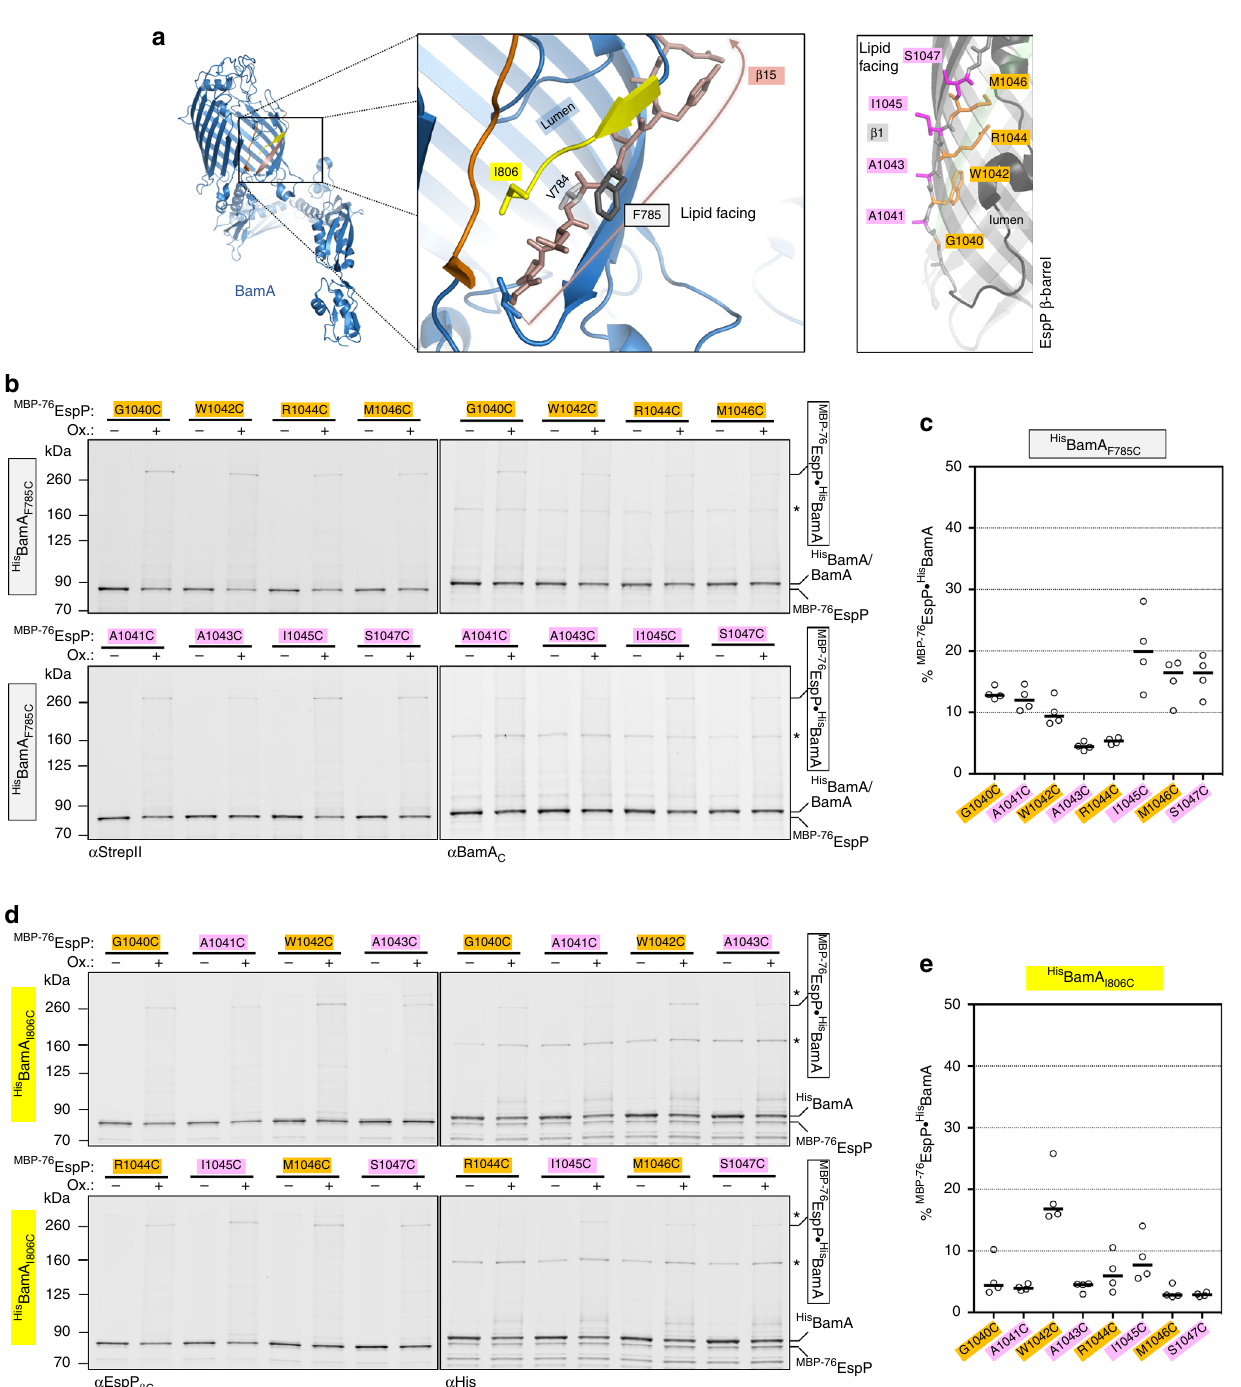
Fig. 4 Bonding of MBP − 76 EspP( β 1) cysteines with lipid-facing cysteines in BamA( β 15/16). a Left, view of outward-facing residues I806 in BamA( β 16) (yellow) and F785 in BamA( β 15) (salmon). Right, view of MBP − 76 EspP( β 1) showing lipid-facing (magenta) and luminal (orange) residues. Residue S1047 is situated at the interface between the outer lea fl et of the OM and the extracellular milieu 54 and is the last membrane embedded residue of β 1. b , d BL21 (DE3) that expressed MBP − 76 EspP with a single cysteine substitution in β 1 and His BamABCDE with a His Bam I806C ( b ) or His BamA F785C ( d ) substitution were mock-treated ( − ) or treated with 4-DPS ( + ). Duplex-immunoblots were then conducted using antibodies/antisera against the N-terminus and C-terminus of MBP − 76 EspP ( α StrepII or α EspP β C ) and His BamA ( α His or α BamA C ) to monitor disul fi de-bond formation between cysteine pairs in vivo. Non-speci fi c bands are denoted (*). Data are representative of at least two independent experiments. c , e Quantitation of disul fi de-bond formation between MBP − 76 EspP ( β 1) and His Bam I806C ( c ) or His BamA F785C ( e ) cysteine pairs in 4-DPS-treated cells. Experiments were performed as in b , d except that only α StrepII was used for probing immunoblots. Bars = median, N = 4. ANOVA and multiple comparison tests are shown in Supplementary Tables 3 and 4. Source data are provided as a Source Data fi